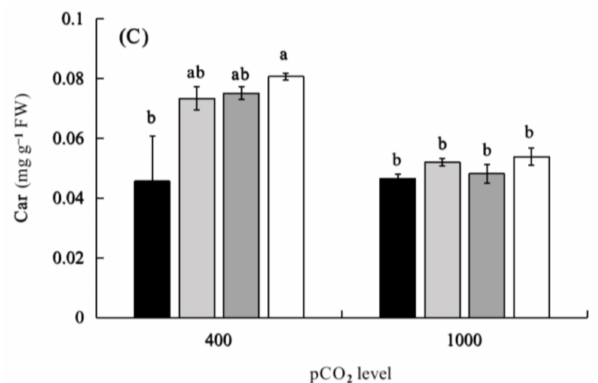
Figure 3. Chlorophyll a ( A ), chlorophyll c ( B ), and carotenoid content ( C ) of S. japonica grown at different pCO 2 levels and copper concentrations. C (control, natural seawater); LCu (low copper concentration, 0.2 µ M); MCu (medium copper concentration, 0.5 µ M); HCu (high copper concentra- tion, 0.2 µ M). All results are shown as mean value ± SD ( n = 3). Different letters indicate statistical differences ( p < 0.05) among experimental treatments.